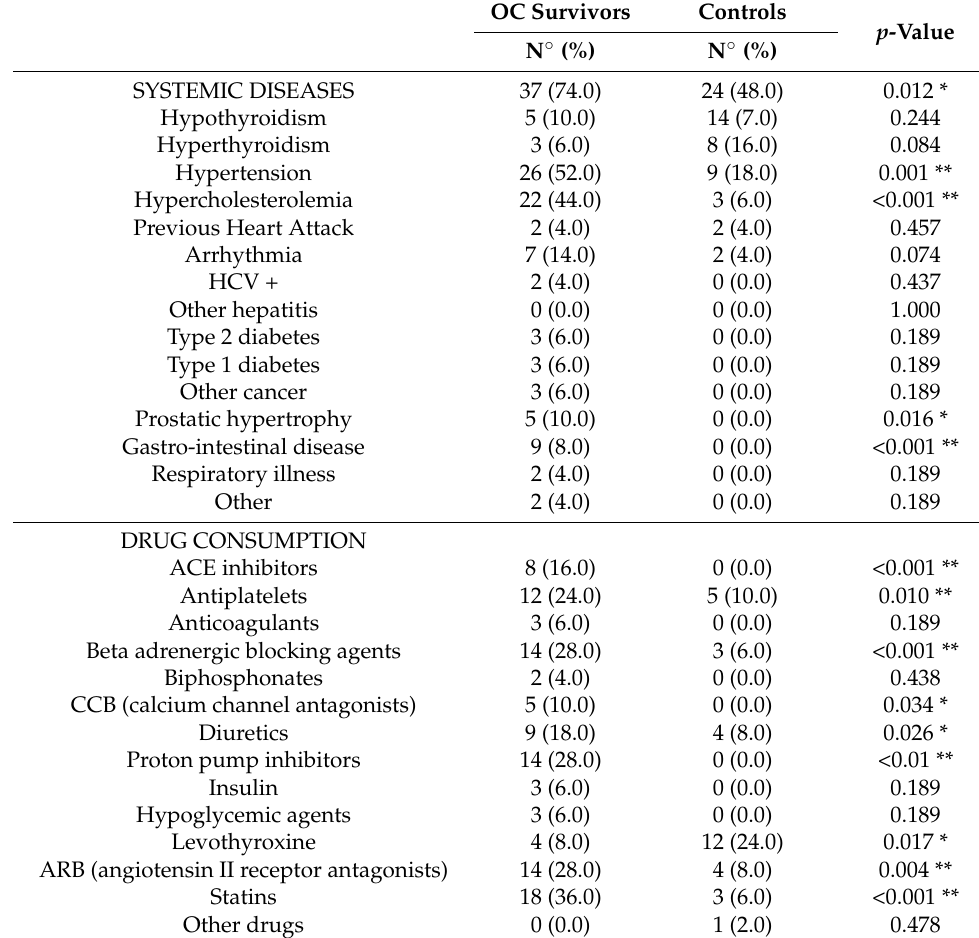
Table 2. Frequency of systemic diseases and drug consumption in the 50 OSCC patients and 50